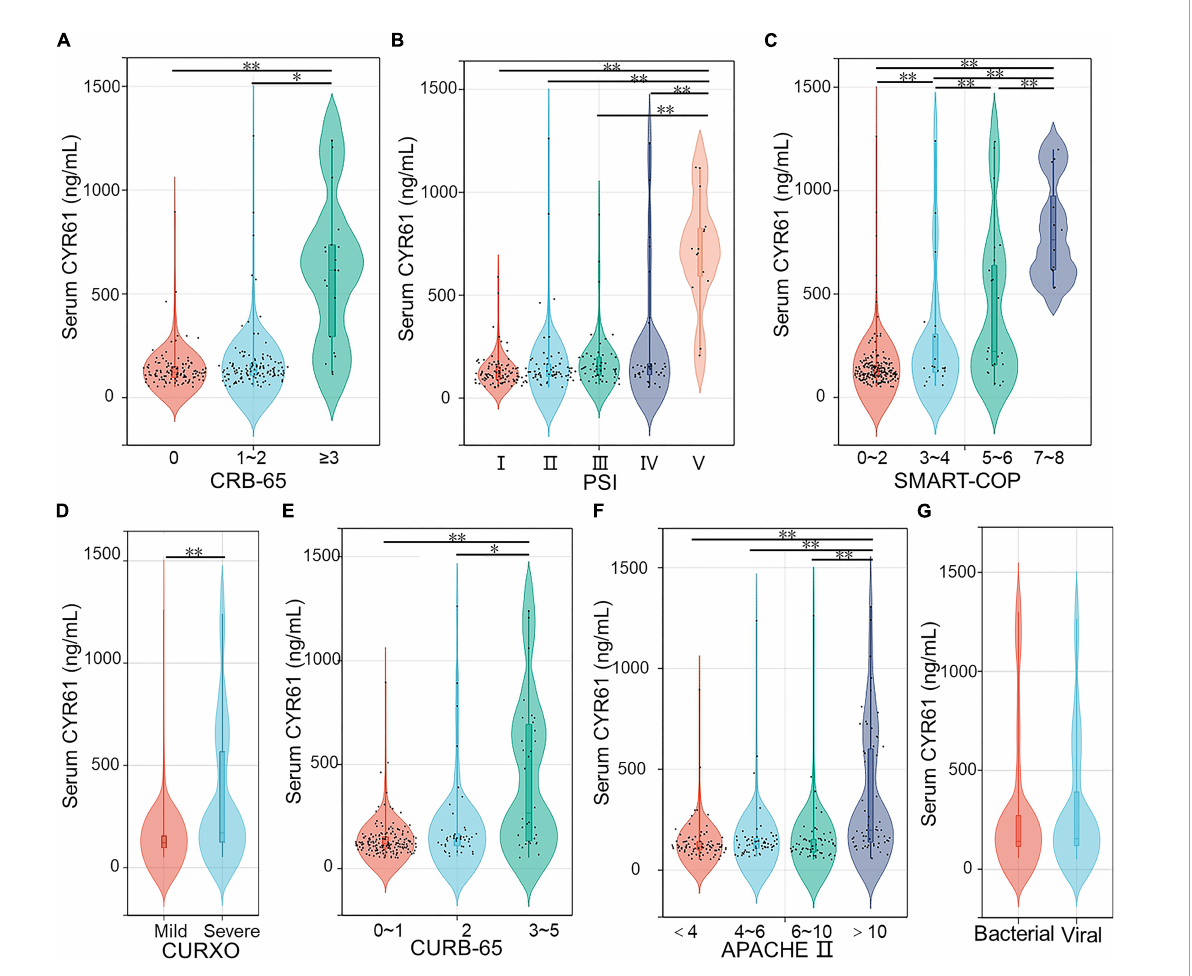
FIGURE1 The levels of serum CYR61 in CAP patients. (A–G) The level of serum CYR61 was measured using ELISA. (A) The levels of serum CYR61 in CAP patients with different CRB-65 score. (B) The levels of serum CYR61 in CAP patients with different PSI score. (C) The levels of serum CYR61 in CAP patients with different SMART-COP score. (D) The levels of serum CYR61 in CAP patients with different CURXO score. (E) The levels of serum CYR61 in CAP patients with different CURB-65 score. (F) The levels of serum CYR61 in CAP patients with different APACHE II score. (G) The levels of serum CYR61 in CAP patients with bacterial infection or viral infection. ∗ P <0.05, ∗∗ P